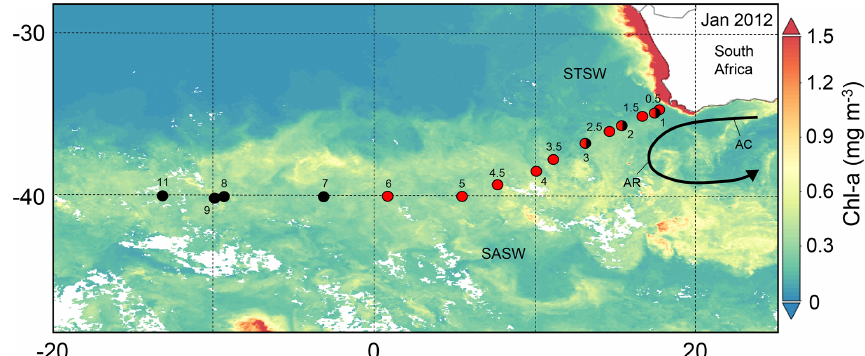
Figure 1. The south-eastern Atlantic stations sampled for dissolved Zn and Co along the GA10 section during UK-GEOTRACES cruises D357 (red circles) and JC068 (black circles), overlying a Visible Infrared Imaging Radiometer Suite (VIIRS) monthly composite image of chlorophyll a concentrations for January 2012 (https://oceancolor.gsfc.nasa.gov/, last access: 7 July 2021). Two transects were completed during D357 between Cape Town and the zero meridian that represent early austral spring 2010 (D357-1; Stations 1, 2, 3, 4, 5 and 6) and late austral spring 2010 (D357-2; Stations 0.5, 1, 1.5, 2.5, 3.5, 4.5), respectively. JC068 took place during austral summer 2011/2012, and we present here only the repeat transect data between Cape Town and 13 ◦ W (Stations 1, 2, 3, 7, 8, 9, 11). STSW: sub-tropical surface water; SASW sub-Antarctic surface water; AC: Agulhas Current; AR: Agulhas